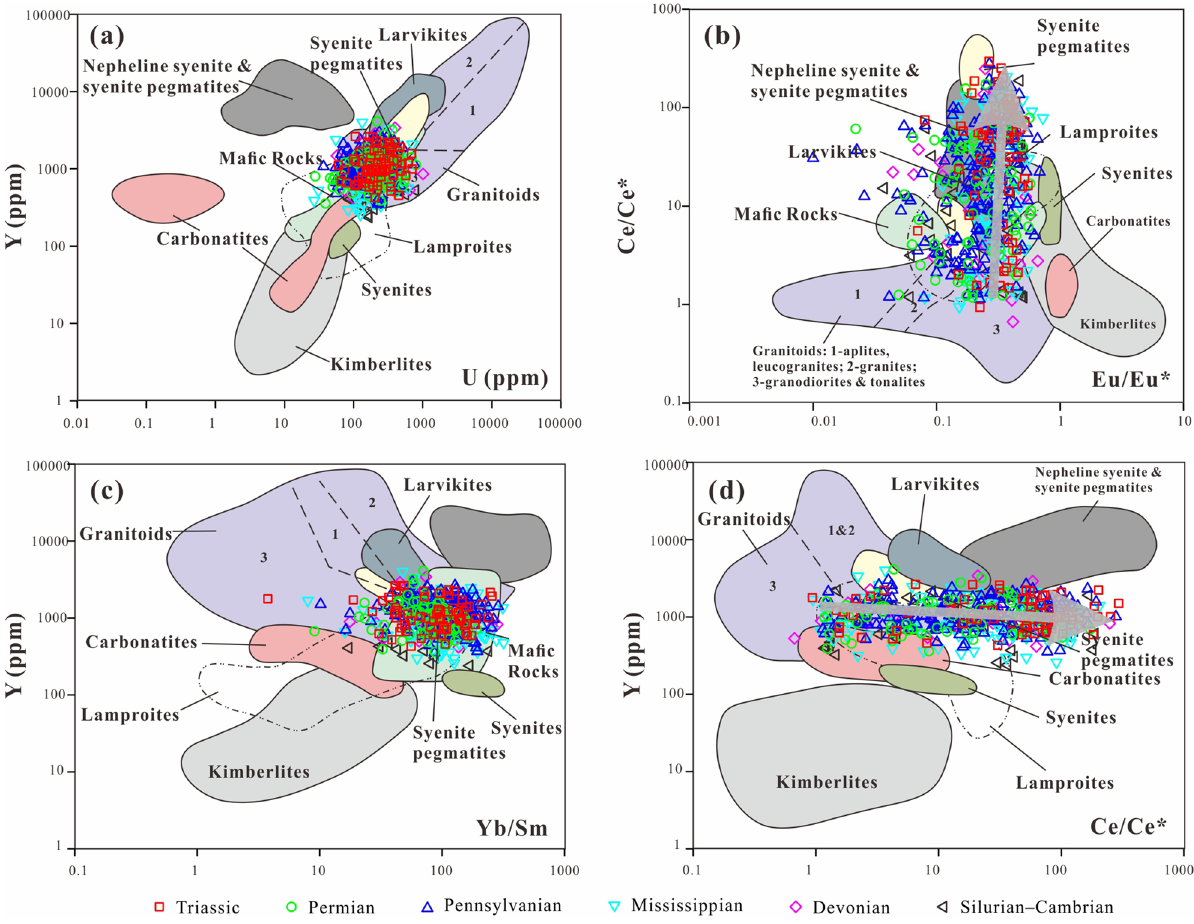
Figure 8. Zircon compositions of (a) U–Y, (b) Eu/Eu * –Ce/Ce * , (c) Yb/Sm–Y, and (d) Ce/Ce * –Y diagrams used as discriminants for different source rock types (modified after 3 ).